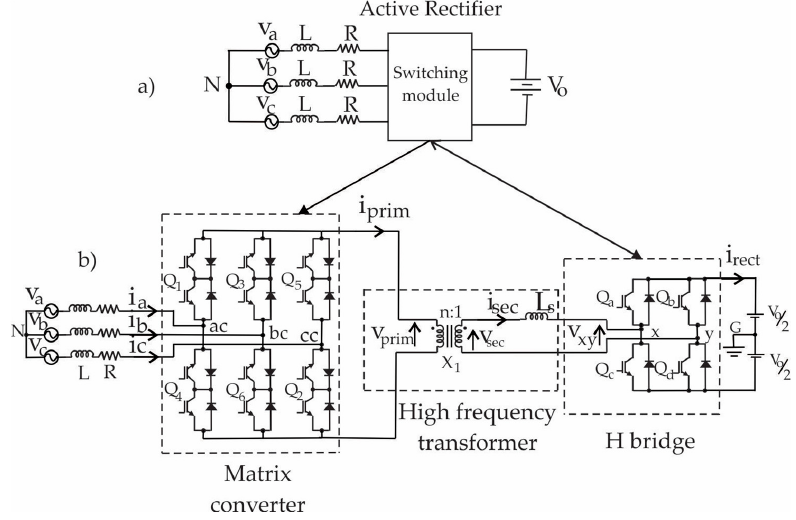
Figure 1. ( a ) Conventional active rectifier; ( b ) Circuit diagram of the proposed modular AC-DC